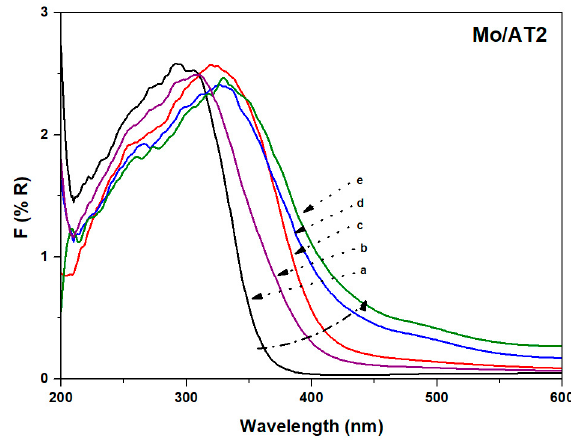
Figure 3. Diffuse reflectance UV-vis spectra of the unpromoted Mo/AT2 catalysts calcined at 673 K with different Mo loadings: a ) AT2, ( b ) 5 wt.%, ( c ) 10 wt.%, ( d ) 15 wt.%, and ( e ) 20 wt.%.